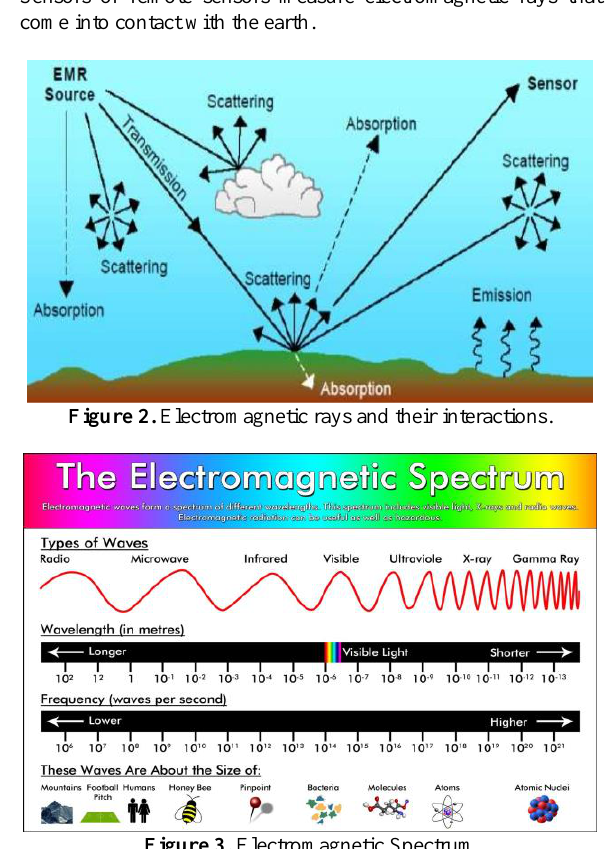
Figure 3. Electromagnetic Spectrum